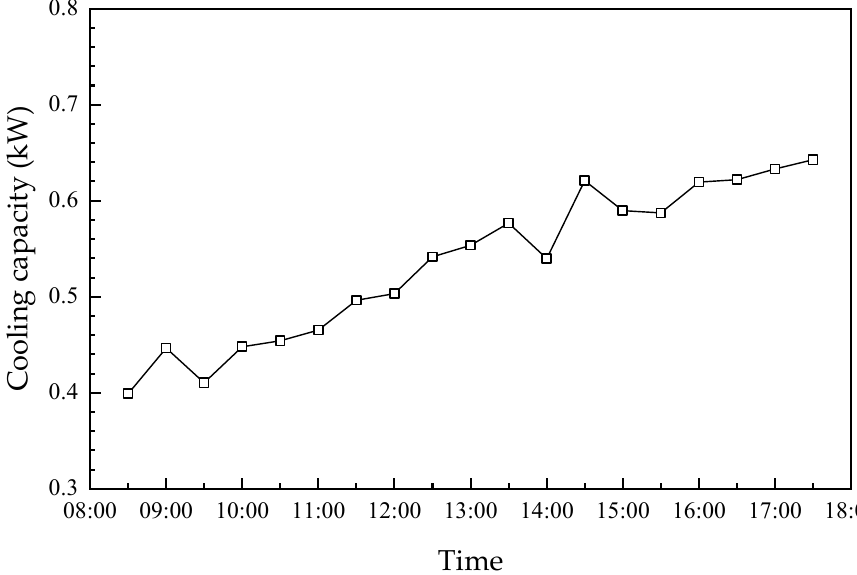
Figure 12. Hourly variation in the cooling capacity.